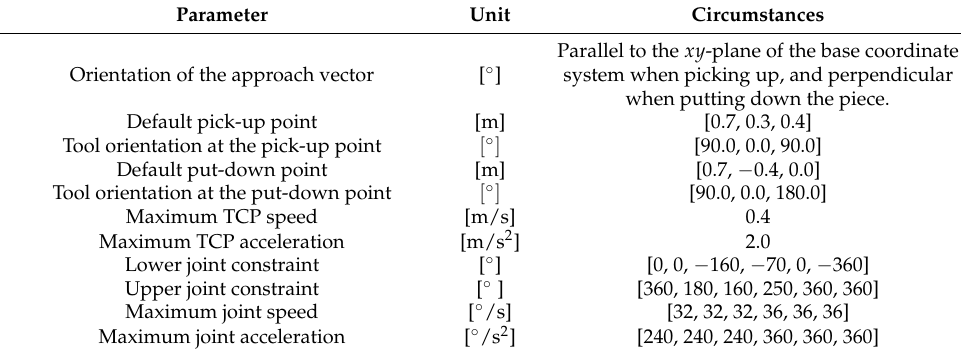
Table 4. Technological parameters of an experiment.